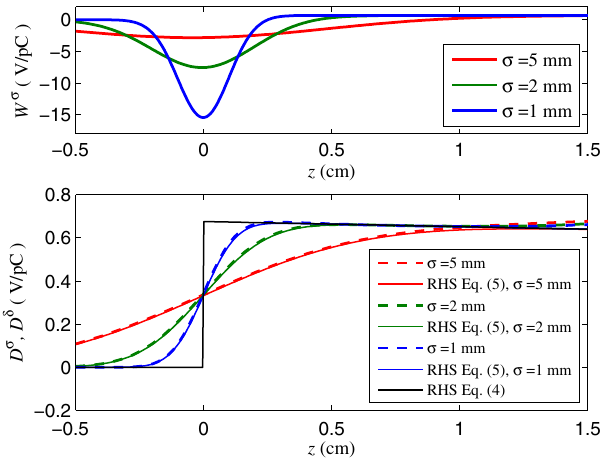
FIG. 1. Wake potentials (top) and functions D (cid:1) ð z Þ for a step- out geometry with r